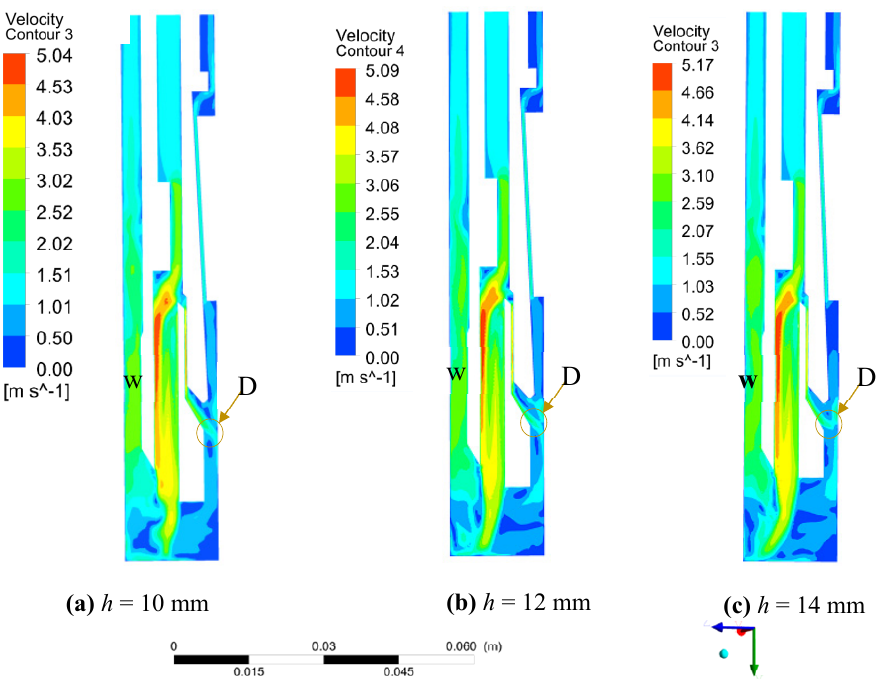
Figure 8. Velocity nephogram of main waterway section ( a ) h = 10 mm; ( b ) h = 12 mm; ( c ) h = 14 mm.